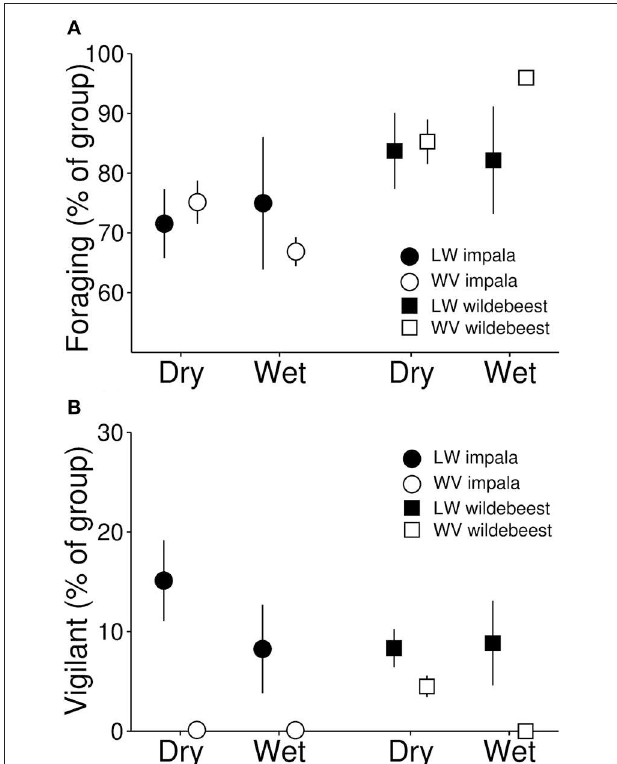
FIGURE 3 | Proportion of individuals engaged in foraging (A) and vigilance behavior (B) recorded during 335 scan observations on 33 groups of impala and 22 groups of wildebeest in Lapalala and 15 groups of impala and 11 groups of wildebeest in Welgevonden. Scan recordings were performed with 1-min intervals for 5min. The figure represents means of group means ± 1 SE.